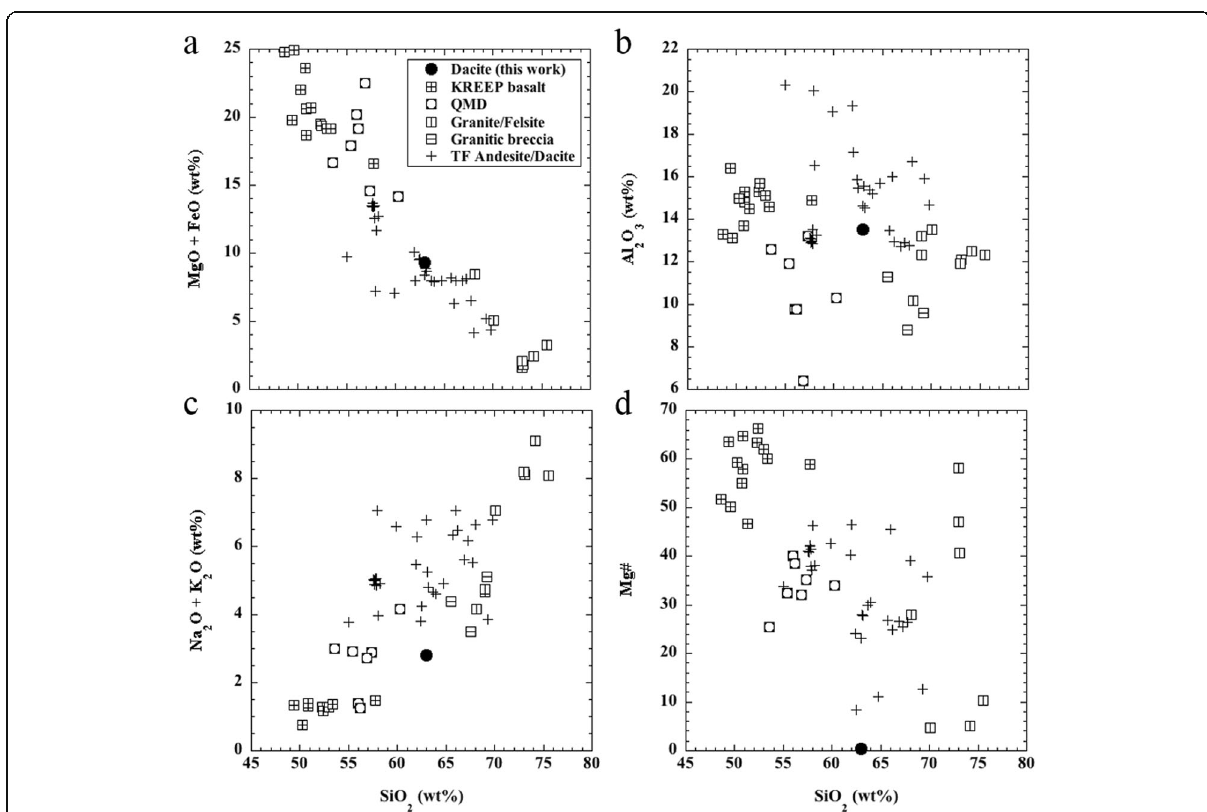
Fig. 9 Comparisons of bulk compositions between the silicic clast (Dacite; this work), Apollo evolved samples and several terrestrial andesite/ dacites (see text): a SiO 2 vs. MgO + FeO, b SiO 2 vs. Al 2 O 3 , c SiO 2 vs. Na 2 O + K 2 O, d SiO 2 vs. Mg#. Rocks shown in the plot include: the silicic clast (dacite; this work); KREEP basalt (Hubbard et al. 1973; Rhodes and Hubbard 1973; Murali et al. 1977; Warren and Wasson 1978; Warren et al.